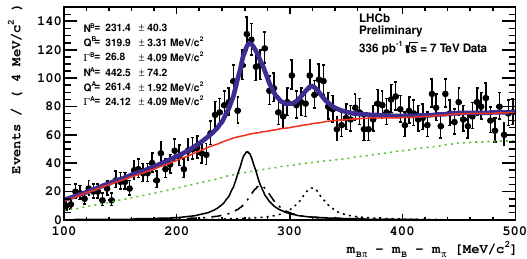
Figure 7. Q ( B 0 π + ) distribution. LHCb data (black markers) and the total fit are superimposed. Individual components contributing to the total fit are combinatorial background and associated production (red, green for → B ∗ 0 π + (solid black), B ∗ + → B ∗ 0 π + (dot-dashed black) and B ∗ + → B 0 π + combinatorial background only), B + 1 2 2